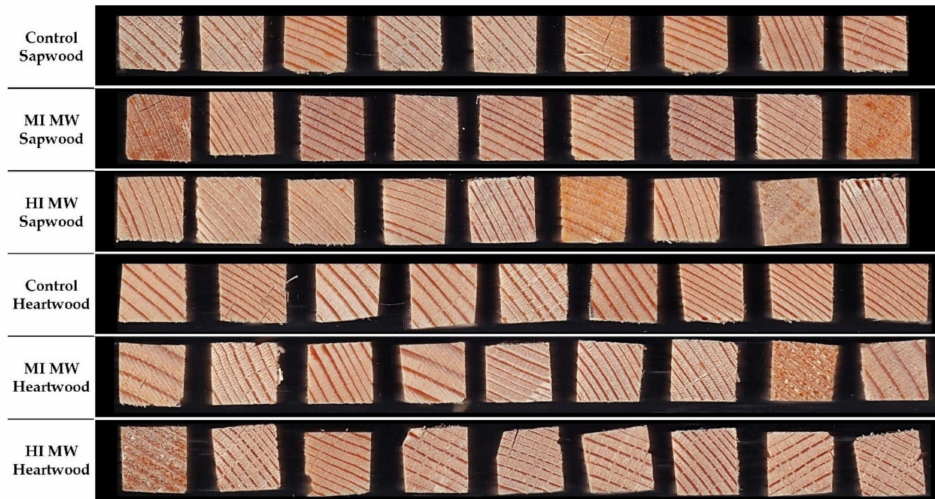
Figure 1. Samples (1.0 × 1.0 cm 2 ) used for pycnometric density measurements. Microwave treatment (MW) was performed at moderate (MI) and high (HI) intensities on the Sapwood and Heartwood of Norway spruce ( Picea abies